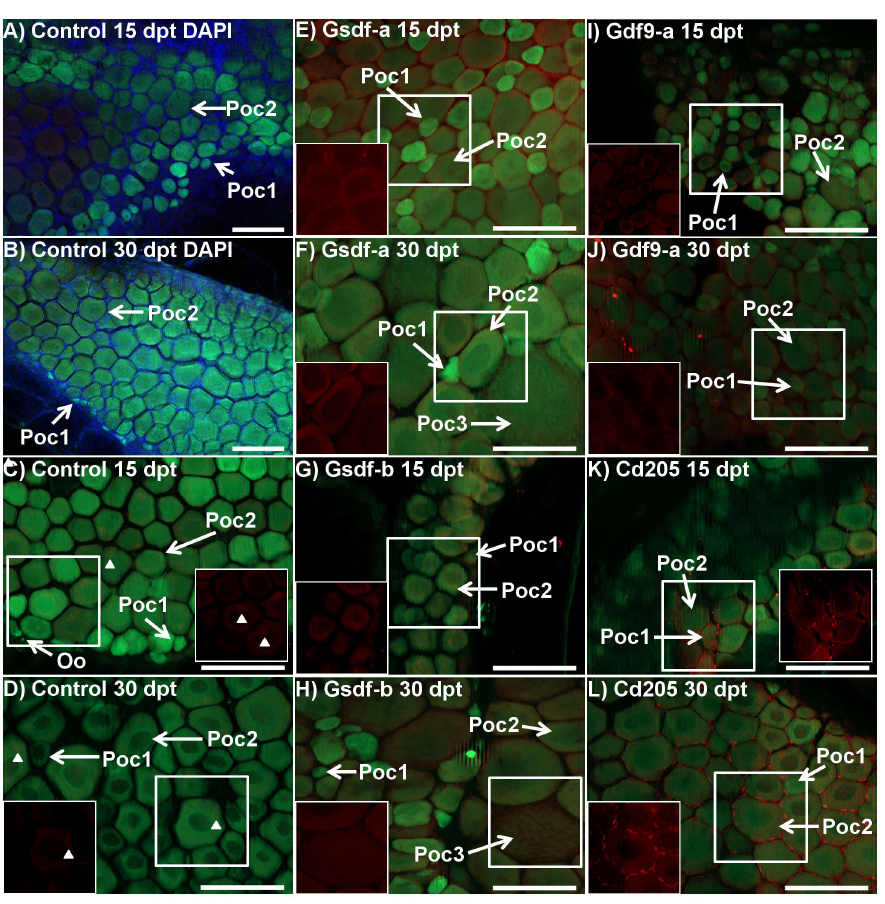
Figure 6. Immunohistochemistry of Bcl2-interacting-killer (Bik) protein in control and treated ovaries of tg ( vas::egfp ) line zebrafish. Merged images combine the eGFP filter (green; germ cell lineage), dsRed filter (red; Bik protein), and DAPI filter (blue; somatic cells) under epifluorescent light. A and B) Control fish at 15 (72.3 mg, 20.5 mm) and 30 (108.4 mg, 25.6 mm) days post treatment (dpt), respectively: DAPI staining (blue) identifies somatic cells which fill the space between stage 1 and stage 2 primary oocytes (green) and around the periphery. C and D) Control fish at 15 and 30 dpt, respectively (A: 57.9 mg, 20.0 mm, B: 184.9 mg, 26.9 mm): Ovaries consisted of stage 1 and stage 2 primary oocytes with some oogonia. Very weak Bik signal was detected in some primary oocytes and some unidentified somatic cells (arrowheads) in only some samples. E and F) Anti-Gsdf-a treated fish at 15 and 30 dpt, respectively (E: 80.0 mg, 22.0 mm, F: 126.0 mg, 25.2 mm): Bik signal was detected in stage 2 primary oocytes but not in stage 1 cells, which were undetectable using only the dsRed filter (in box). Some stage 3 previtellogenic oocytes were seen. G and H) Anti-Gsdf-b treated fish at 15 and 30 dpt, respectively (G: 26.8 mg, 15.0 mm, H: 98.7 mg, 23.8 mm): Bik signal was detected in stage 2 primary and stage 3 previtellogenic oocytes. I and J) Anti-Gdf9-a treated fish at 15 and 30 dpt, respectively (I: 48.5 mg, 19.7 mm, J: 73.9 mg, 21.8 mm): the ovary consisted of presumptive stage 1 and 2 primary oocytes with a scattered distribution. Bik signal was detected in oocytes from both stages (in box). K and L) Anti-Cd205 treated fish at 15 and 30 dpt, respectively (K: 72.8 mg, 21.1 mm, L: 190.8 mg, 29.0 mm): Bik signal was detected in both germ cells and supporting somatic cells surrounding stage 1 and stage 2 primary oocytes. The signal in somatic cells was particularly strong. White boxes identify area being shown with dsRED filter only. Poc1 – stage 1 primary oocyte, Poc2 – stage 2 primary oocyte, Oo – oogonia, Poc3 – stage 3 previtellogenic oocyte. All scalebars represent 100 m